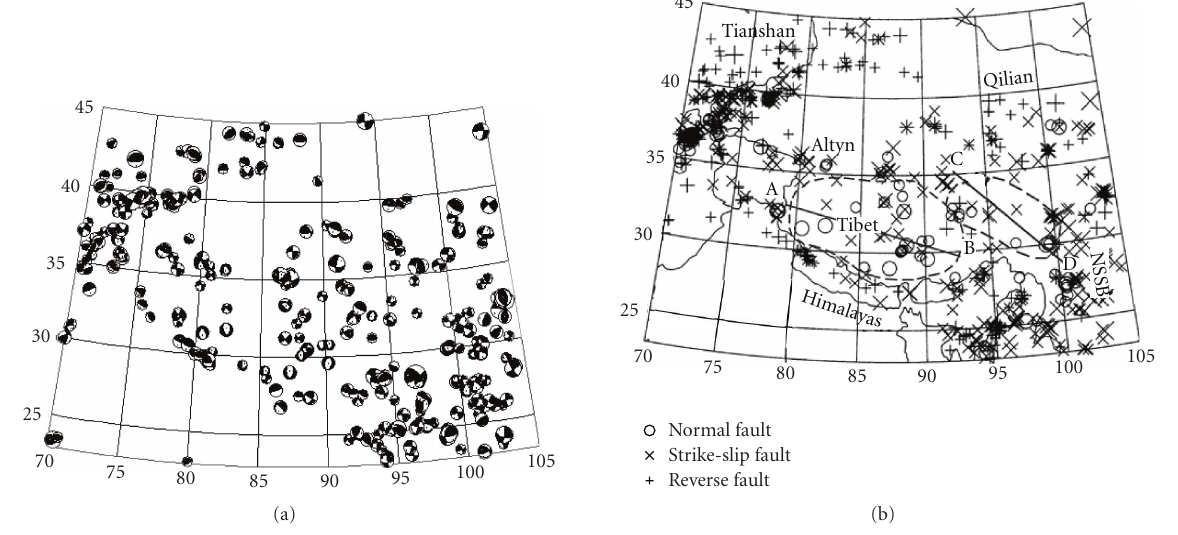
Figure 2: (a) Fault plane solutions of events. (b) Distribution of normal, thrust, and strike-slip faulting events. The Tibetan plateau is surrounded by the Himalayas, Altyn, Qilian, and NSSB. Open circle: normal faulting event; Cross: strike-slip faulting event; Plus: reverse faulting event. Regions AB (the western part of the normal faulting event region, Lhasa block) and CD (the eastern part of the normal faulting event region, Qiangtang-Changdu region) enclosed with dashed lines.